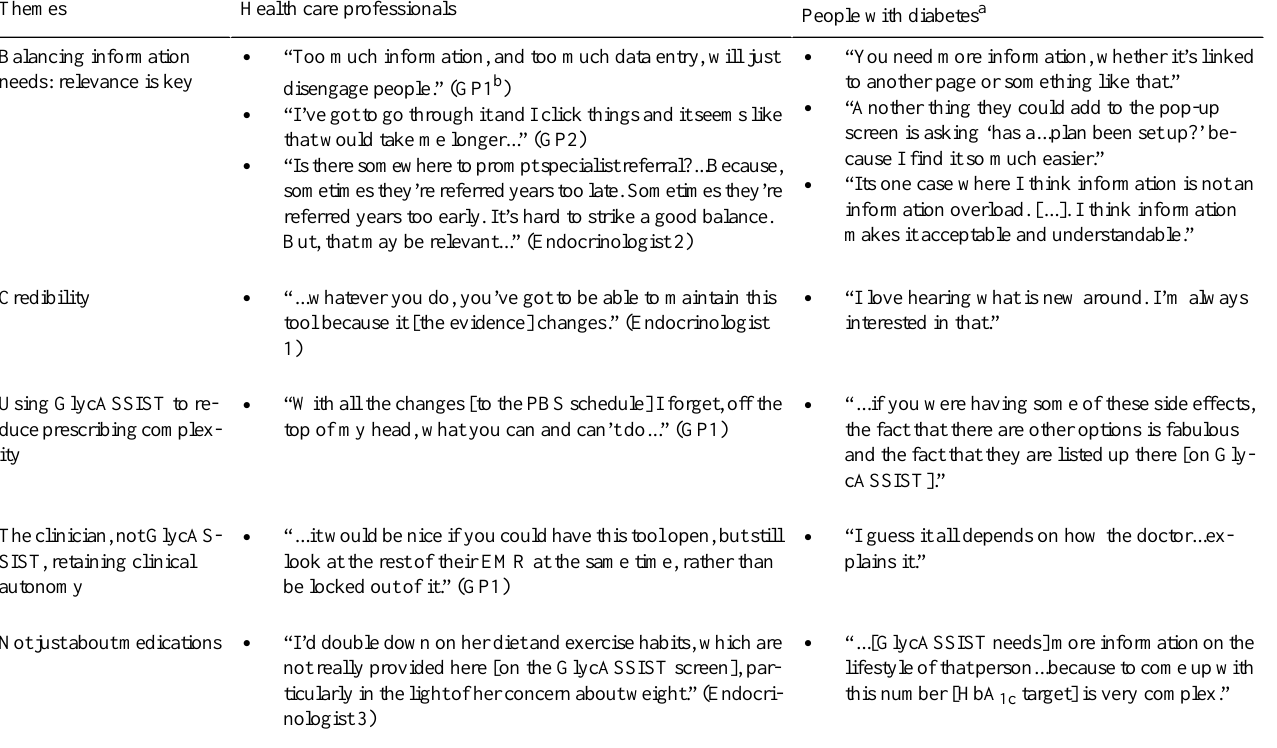
People with diabetes a Health care professionalsThemes